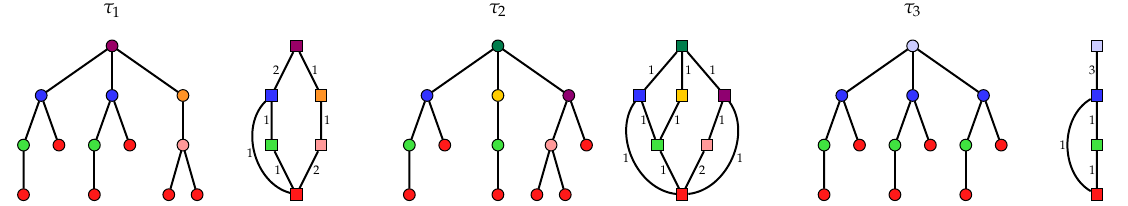
Figure 1. Trees and their DAG (Directed Acyclic Graph) reduction. In the tree, roots of isomorphic subtrees are colored identically. In the DAG, vertices are equivalence classes colored according to the class of isomorphic subtrees that they